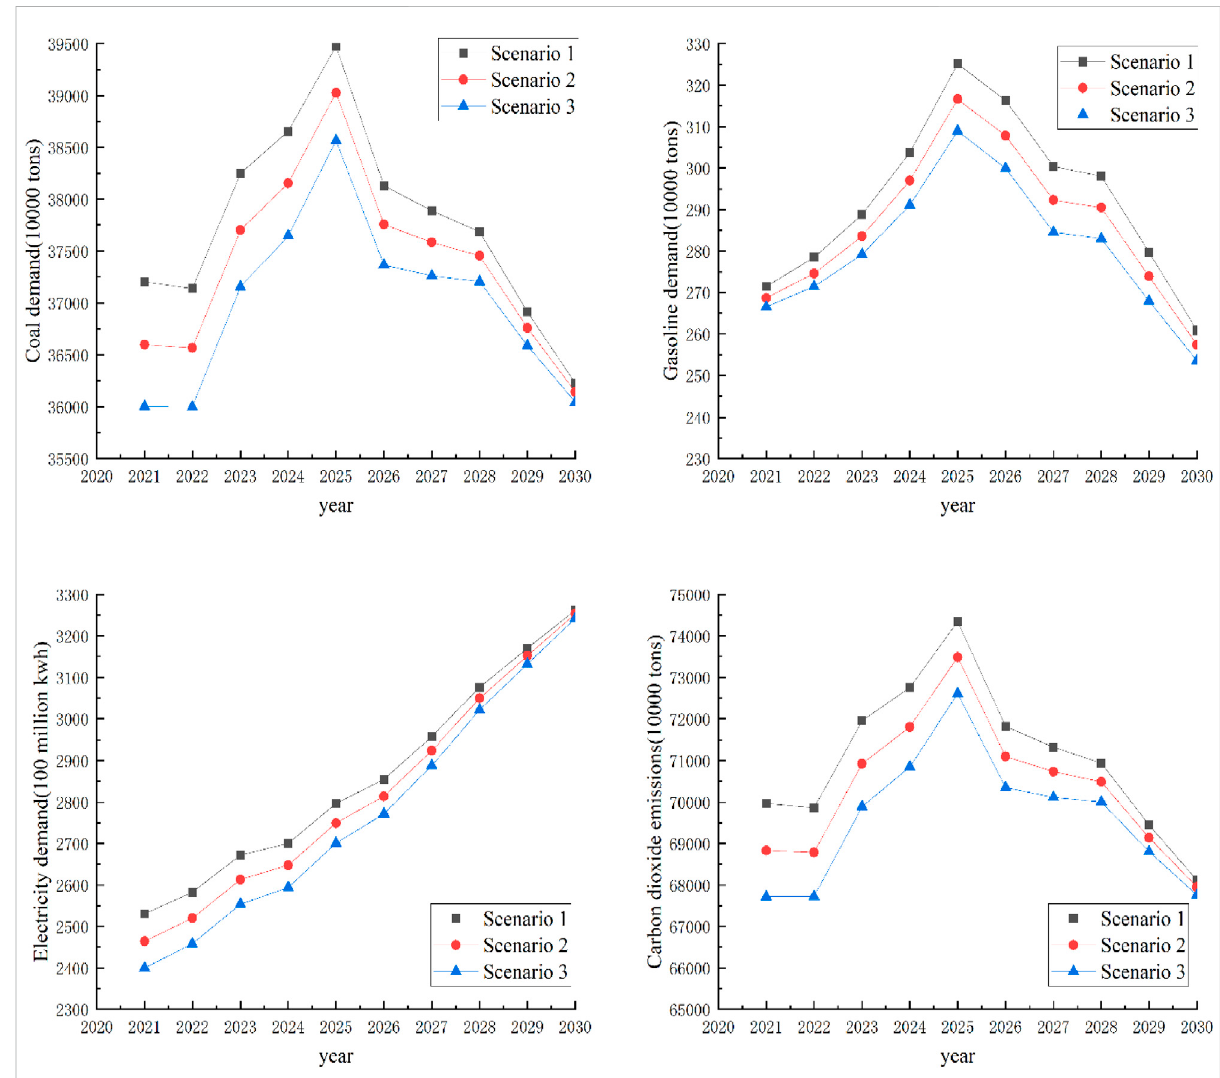
FIGURE 5 The changing trend of coal, gasoline, electricity demand and carbon dioxide